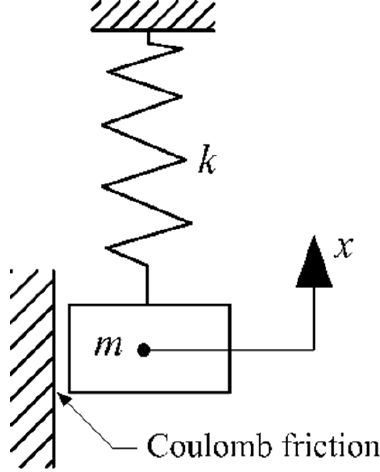
Figure 9. Coulomb friction model of a SDOF.